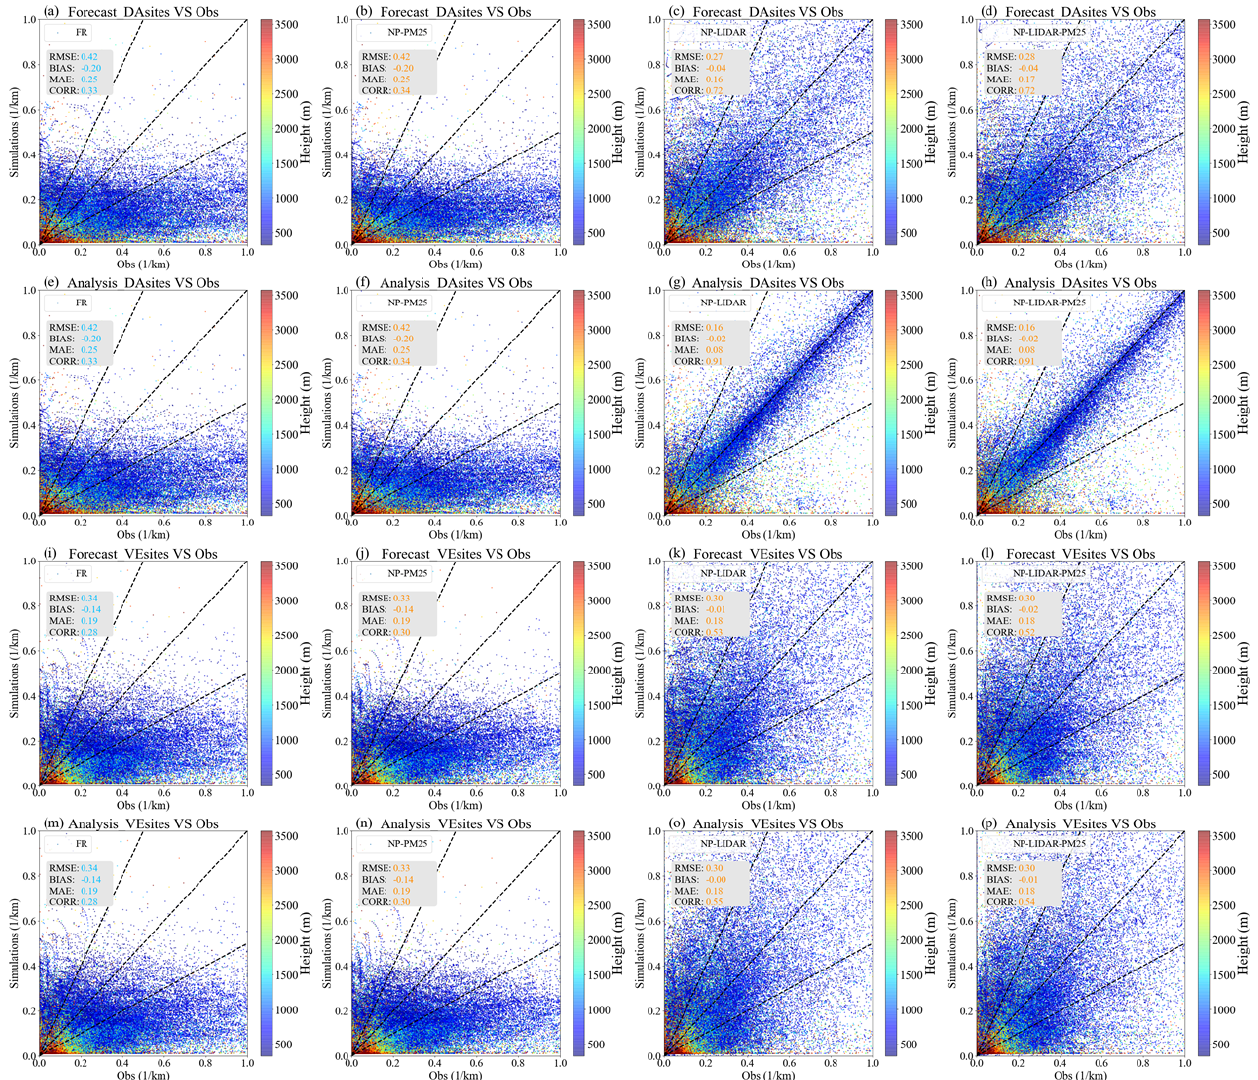
Figure 8. Scatterplots of the modeled hourly extinction coefficients at 550nm versus the ground lidar hourly aerosol extinction coefficients at 532nm (km − 1 ) of forecasts of FR (a) / (i) , forecasts of NP-PM25 (b) / (j) , forecasts of NP-LIDAR (c) / (k) , forecasts of NP-LIDAR-PM25 (d) / (l) , analysis of FR (e) / (m) , analysis of NP-PM25 (f) / (n) , analysis of NP-LIDAR (g) / (o) , and analysis of NP-LIDAR-PM25 (h) / (p) , which are averaged among DA sites/VE sites. The three dashed black lines correspond to the 1 : 2, 1 : 1, and 2 : 1 lines in each